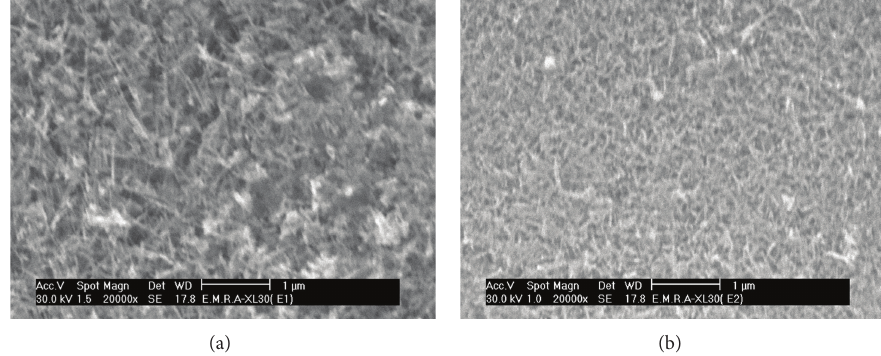
Figure 2: SEM images of ITO thin film with a thickness of 199nm: (a) as-deposited, (b) annealed at 600 ∘ C.